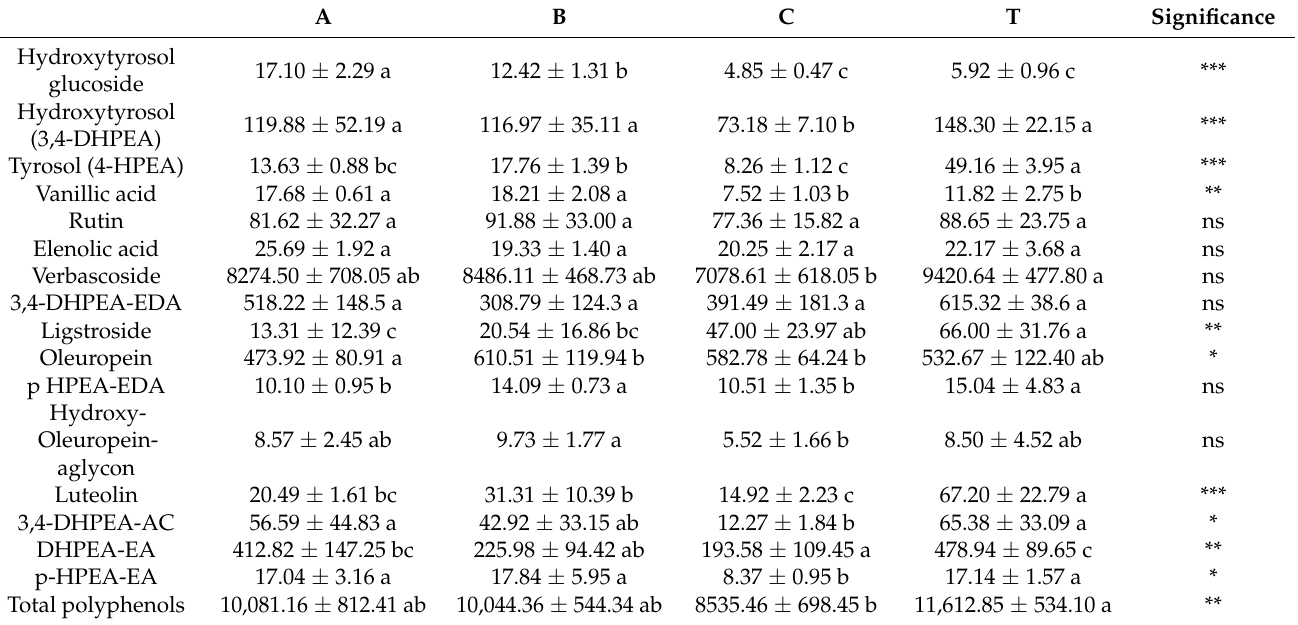
Table 2. Phenolic profiles and total phenolic composition in drupes treated with three biostimulants: A (tropical plants extract), B (glycine betaine), and T ( Trichoderma ) all compared with C (control). Concentrations were expressed as µ g g − 1